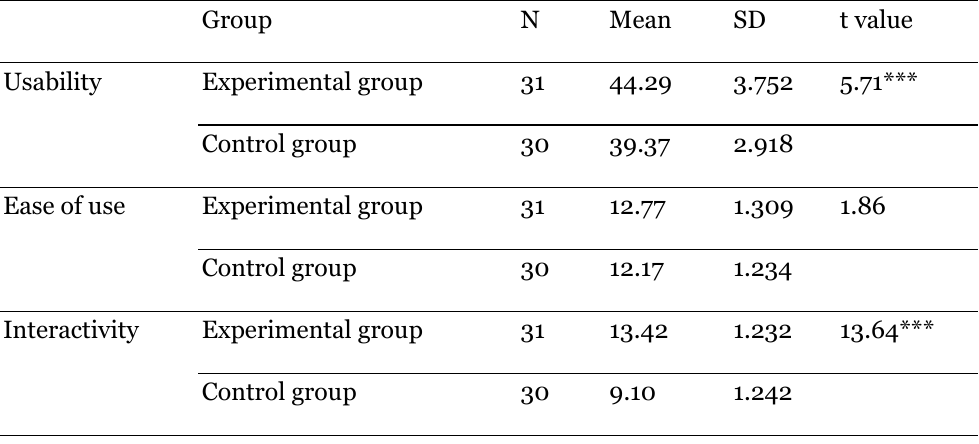
T-Test Result of the Experimental Group/ Control Group Group N Mean SD t value Usability Experimental group 31